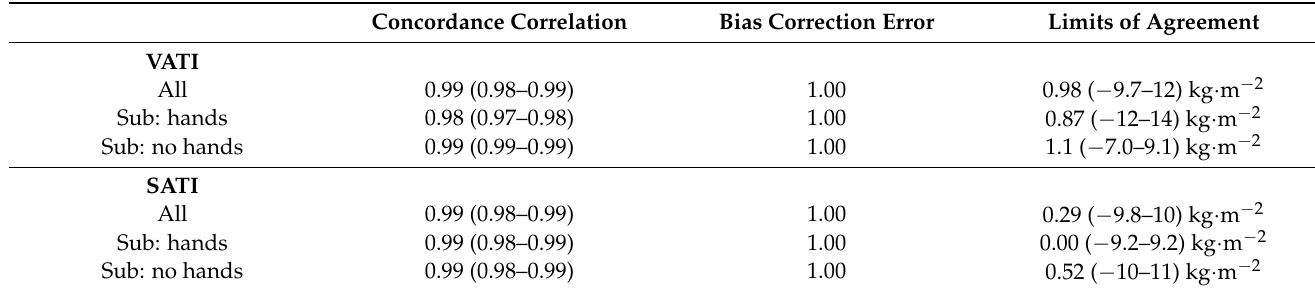
Table 2. Cont . Concordance Correlation Bias Correction Error Limits of